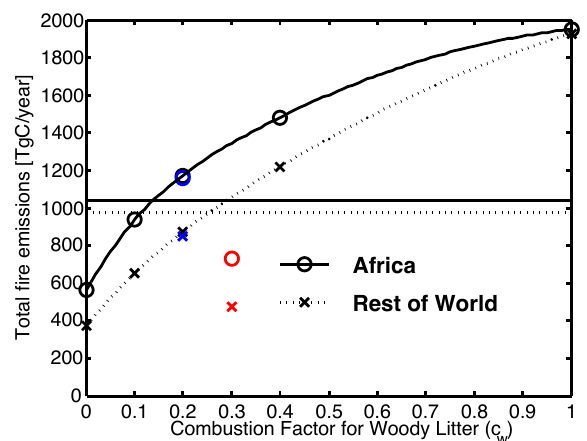
Fig. 2. Sensitivity of average global fire emissions 1997–2009. The horizontal lines show GFED3 emissions during the same period. Blue symbols: combustion efficiency for herbaceous fuel reduced from 1 to 0.9. Red symbols: litter turnover adjusted to match ob- served fuel